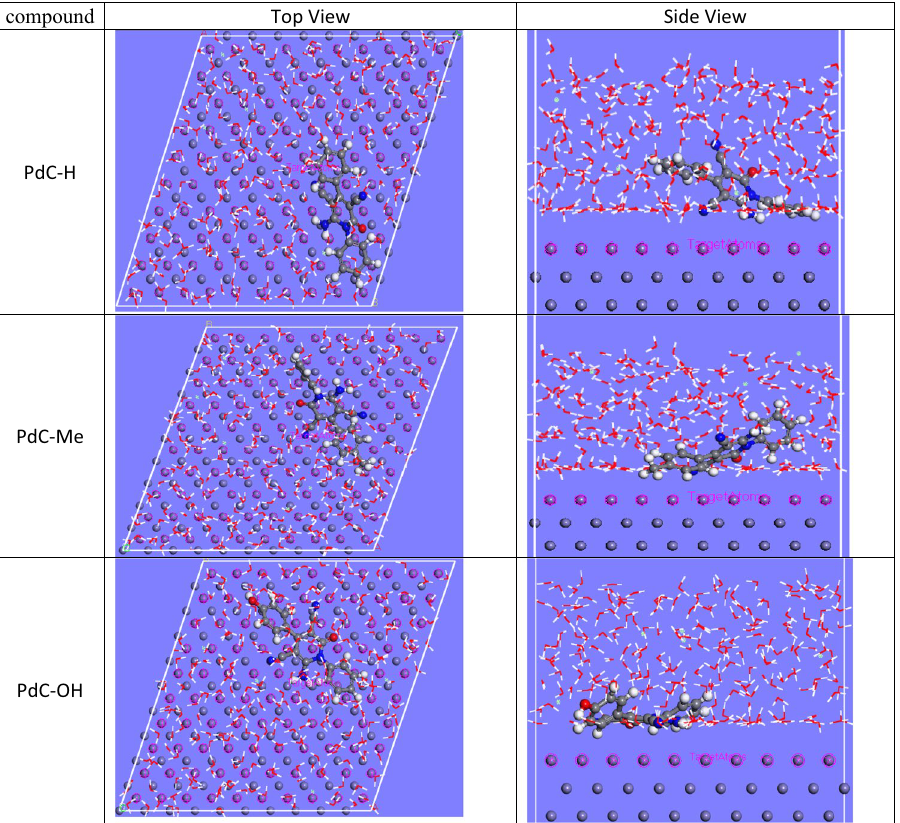
Figure 12. Top and Side Views for the most stable adsorption equilibrium position for studied compounds (PdC-H, PdC-Me and PdC-OH) on the carbon steel.